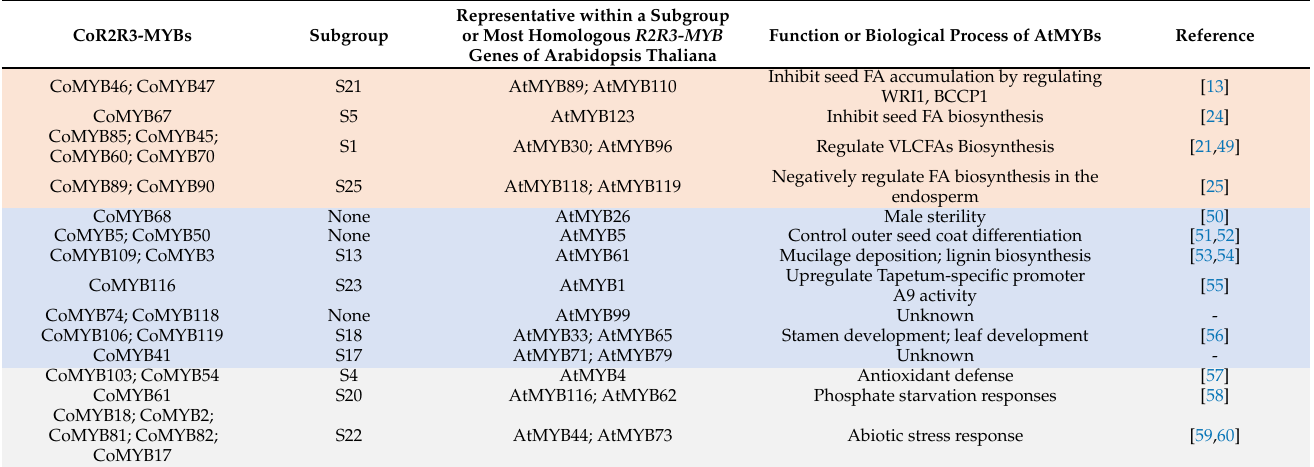
Table 3. The biological processes or potential functions that 28 CoR2R3-MYBs are involved